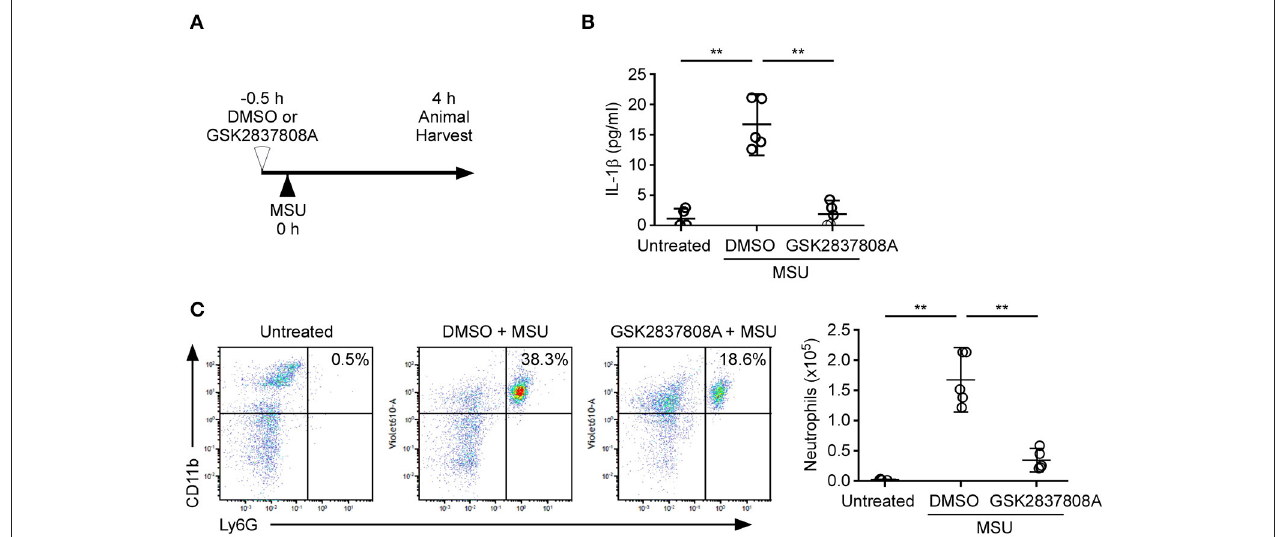
FIGURE 5 | Protective effect of GSK2837808A on MSU-induced peritonitis. (A) Schematic presentation of MSU-induced peritonitis in mice. (B) Determination by ELISA of IL-1 β in the peritonea of mice treated for 4h with intraperitoneal injection of MSU in the presence or absence of GSK2837808A. (C) Absolute number of CD45 + /CD11b + /Ly6G + neutrophils in the peritonea of mice treated for 4h with intraperitoneal injection of MSU in the presence or absence of GSK2837808A. Each symbol represents an individual mouse ( n = 5 per group); small horizontal lines indicate the mean ± SD of the data from two independent experiments. All results were analyzed with the ANOVA test followed by post hoc test. ** P <